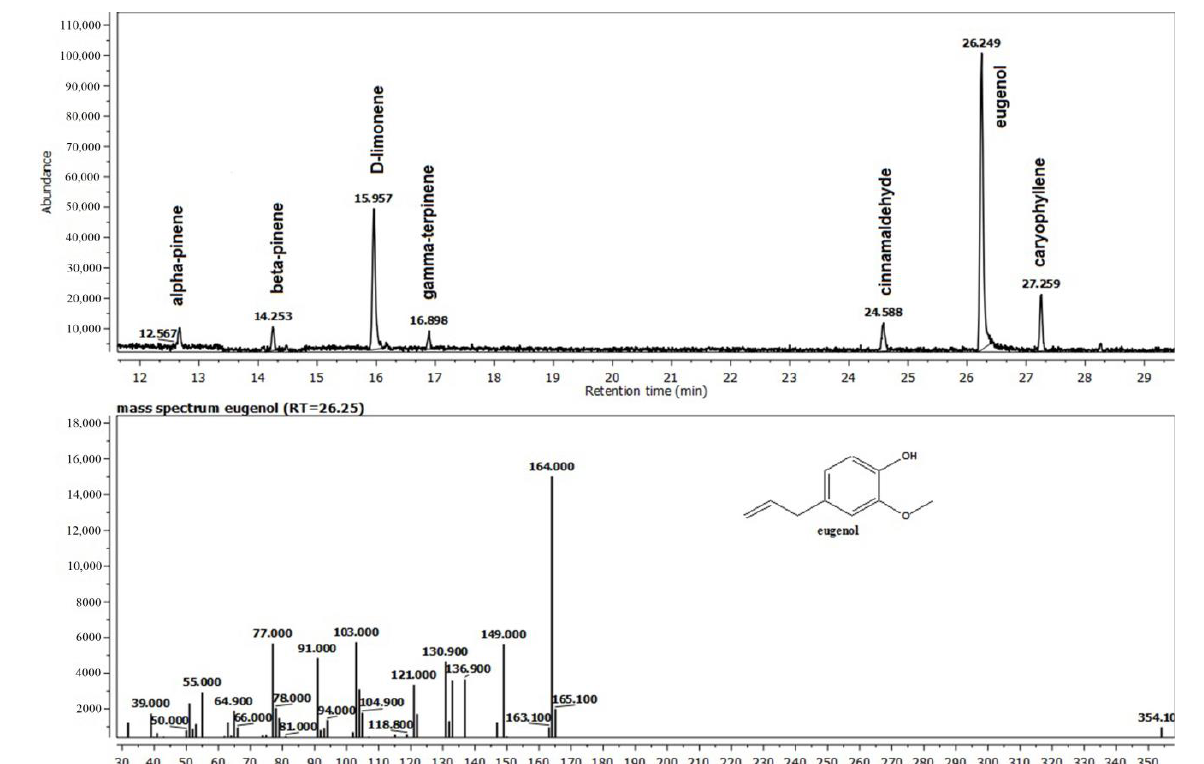
Figure 1. The composition of the Oregano ® oil (O) recovered from the gel G1O.